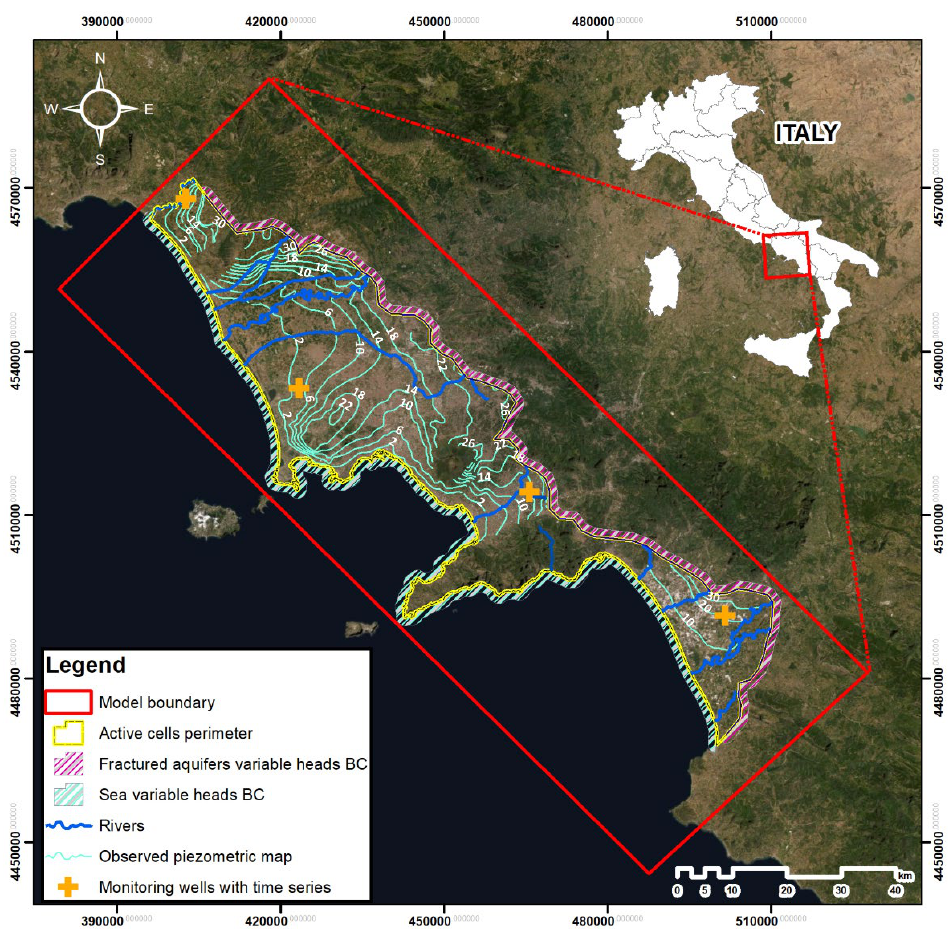
Figure 1. Model location with initial heads and boundary conditions (BCs).